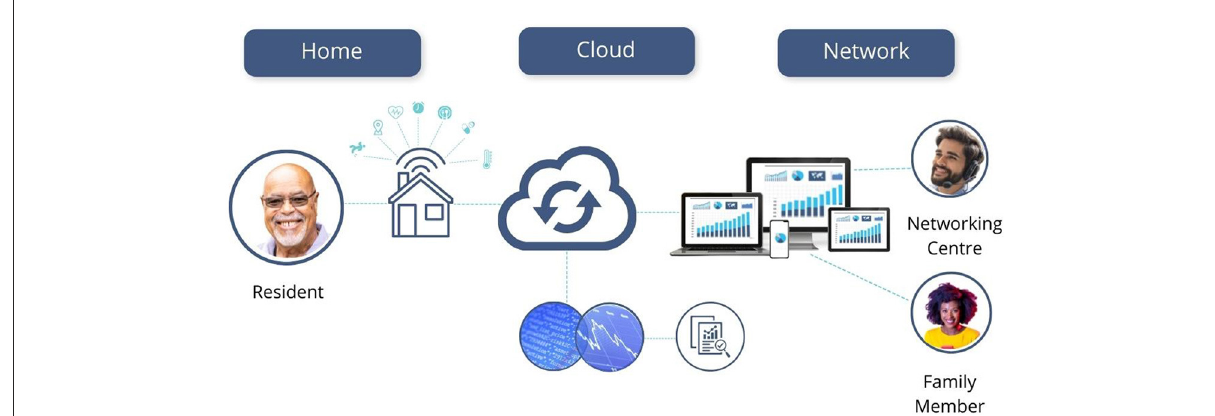
FIGURE6 Network of care.